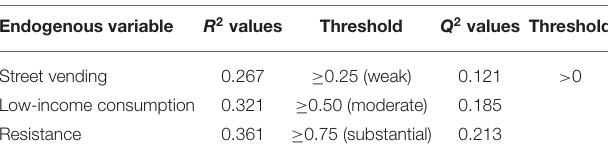
TABLE 3 | Determination coefficients ( R 2 ) and predictive relevance (Q 2 ) of endogenous (omission distance = 7).